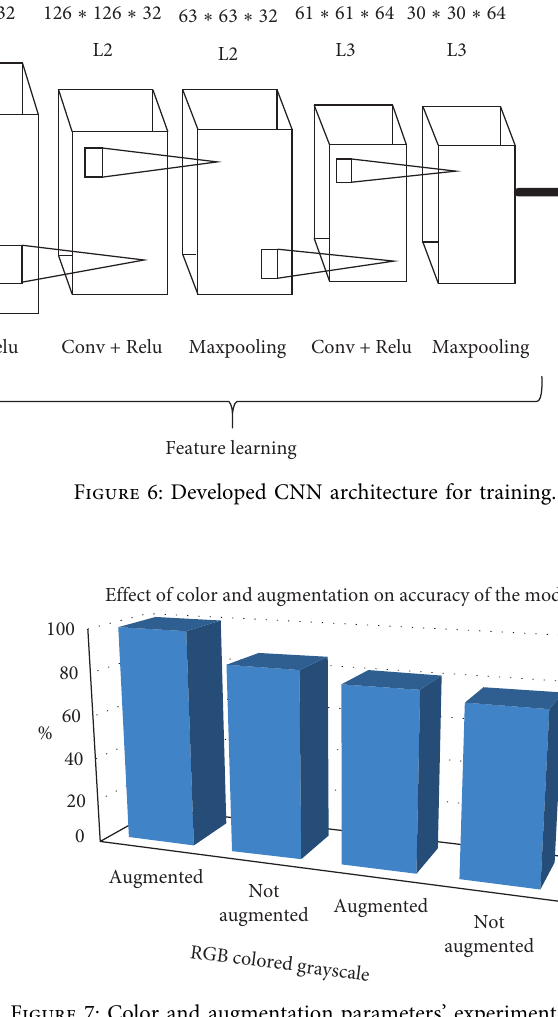
Figure 7: Color and augmentation parameters’ experiment